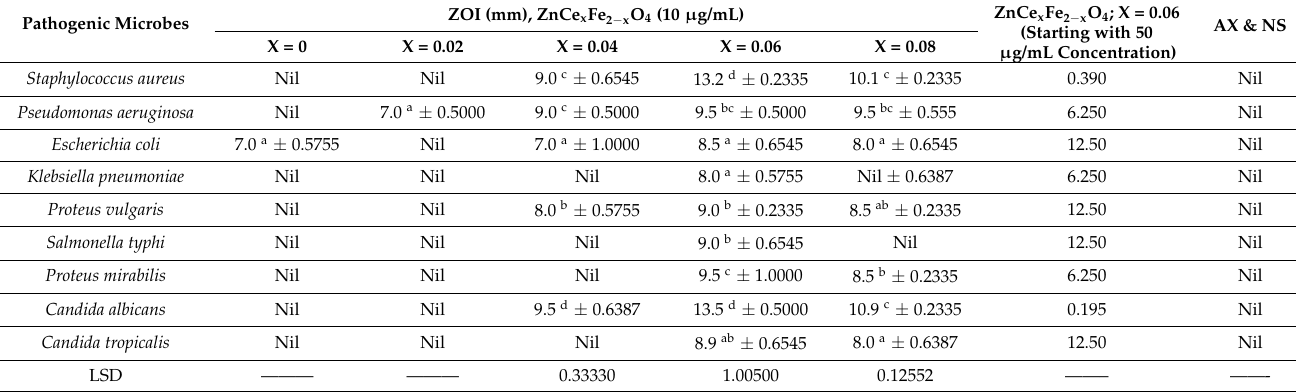
Table 2. Antibacterial and antifungal activities of ZnCe x Fe 2 − x O 4 against some multi-drug resistant bacteria and pathogenic Candida species according to ZOI (mm) and MIC (µg/mL).